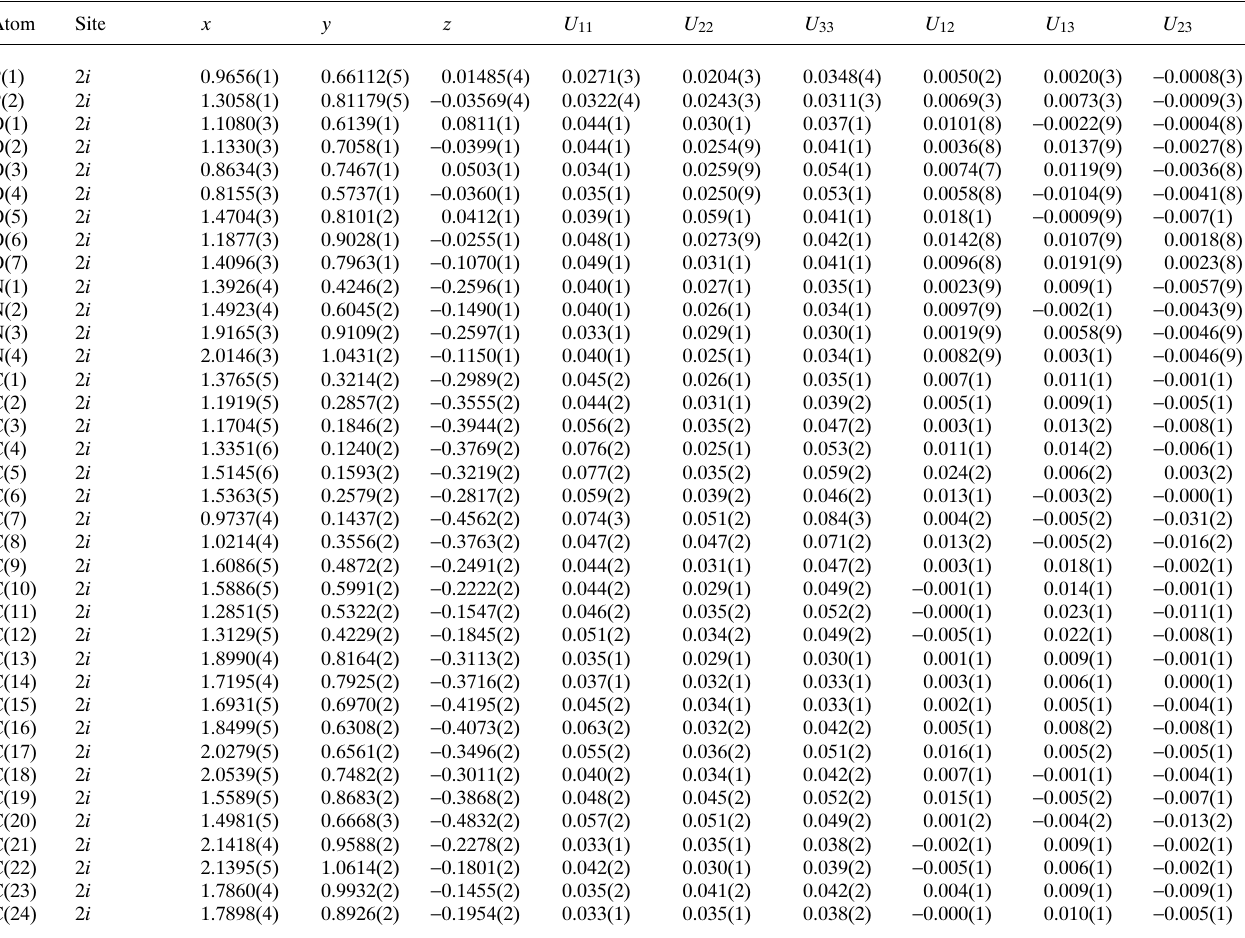
Table 3. Atomic coordinates and displacement parameters (in Å 2 ) .